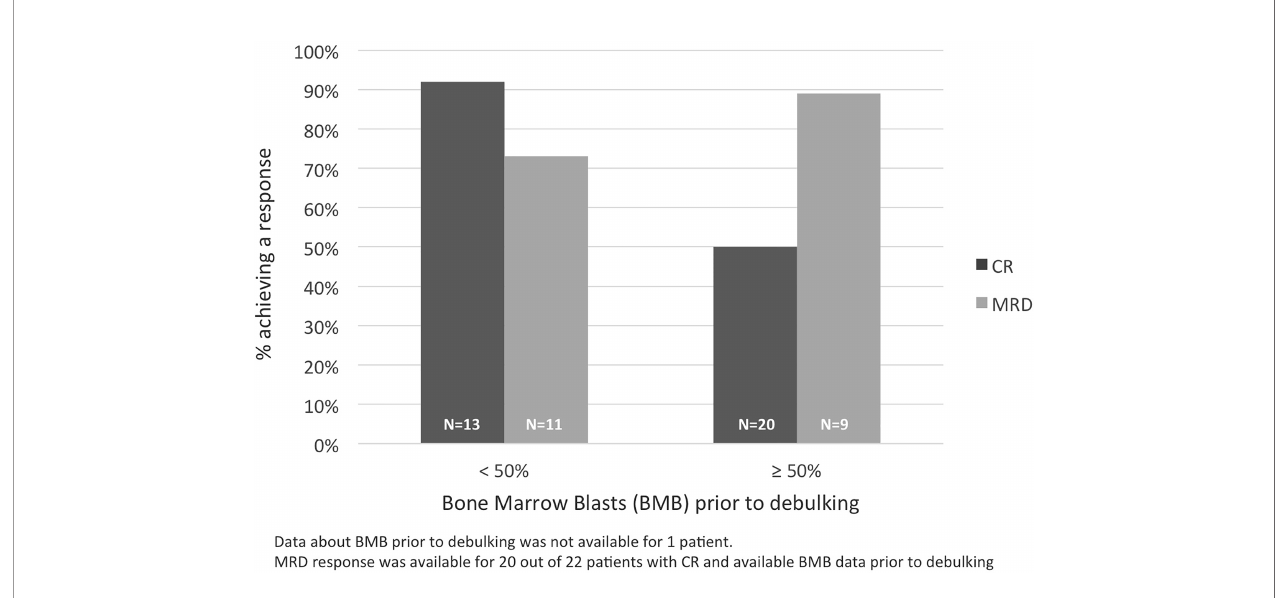
FIGURE 1 | CR and MRD responses according to baseline bone marrow